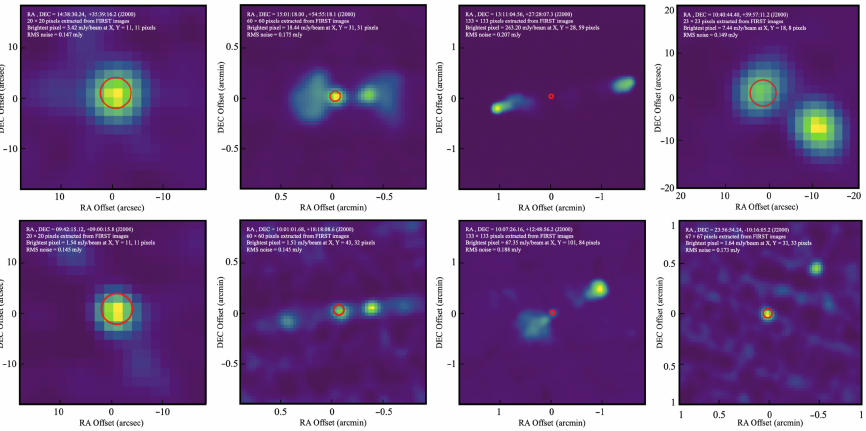
Figure 13. Examples of radio morphology classified by the FIRST Classifier [76]. From left to right : Compact, FRI, FRII and BENT. The red circle in each panel shows the SDSS fibre